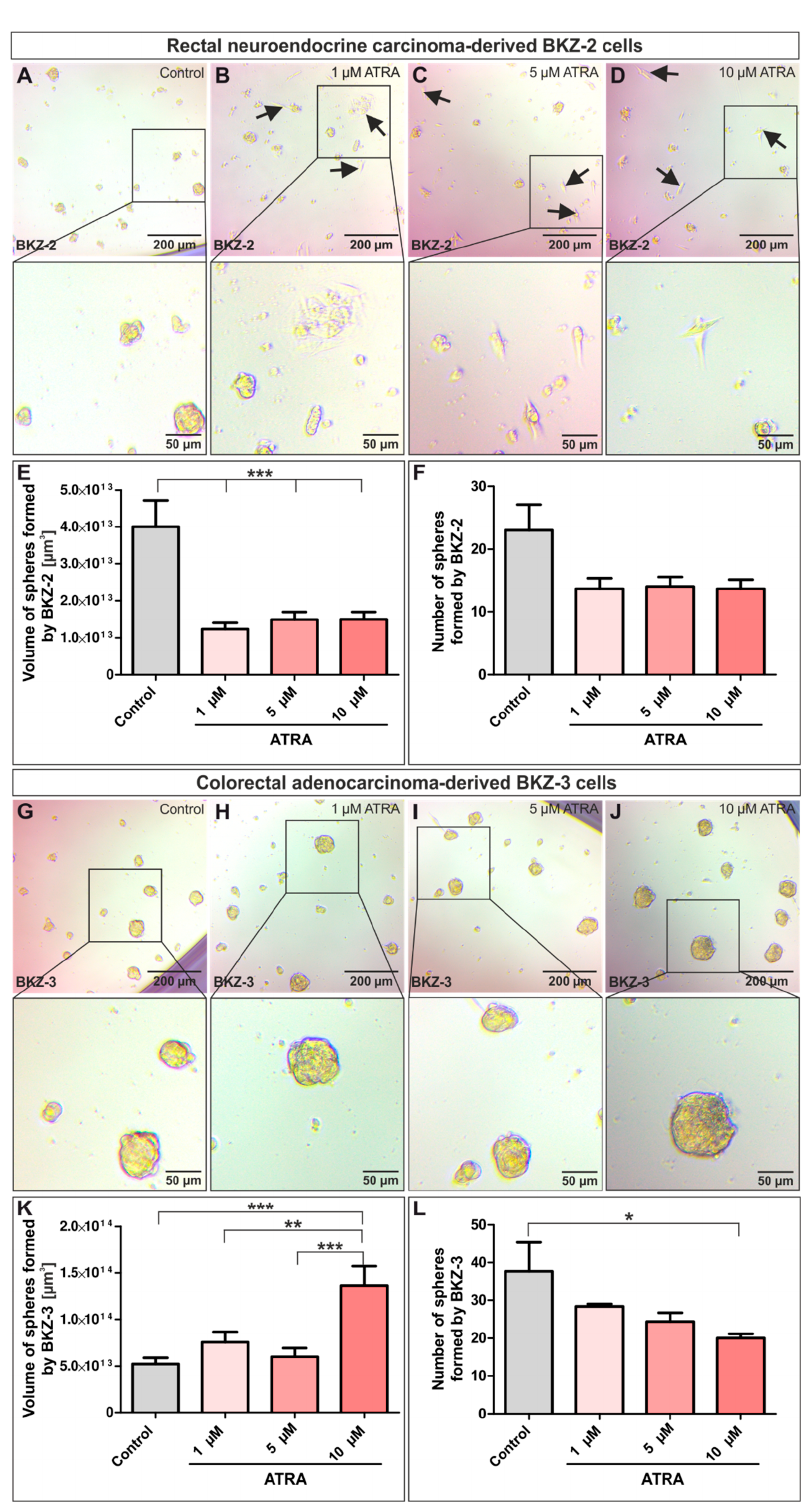
Figure 9. All-trans retinoic acid (ATRA) reduce number of BKZ-2 and BKZ-3 formed spheres respectively, but cause opposed effects concerning sphere volume of BKZ-2 and BKZ-3. Cells were cultured in an